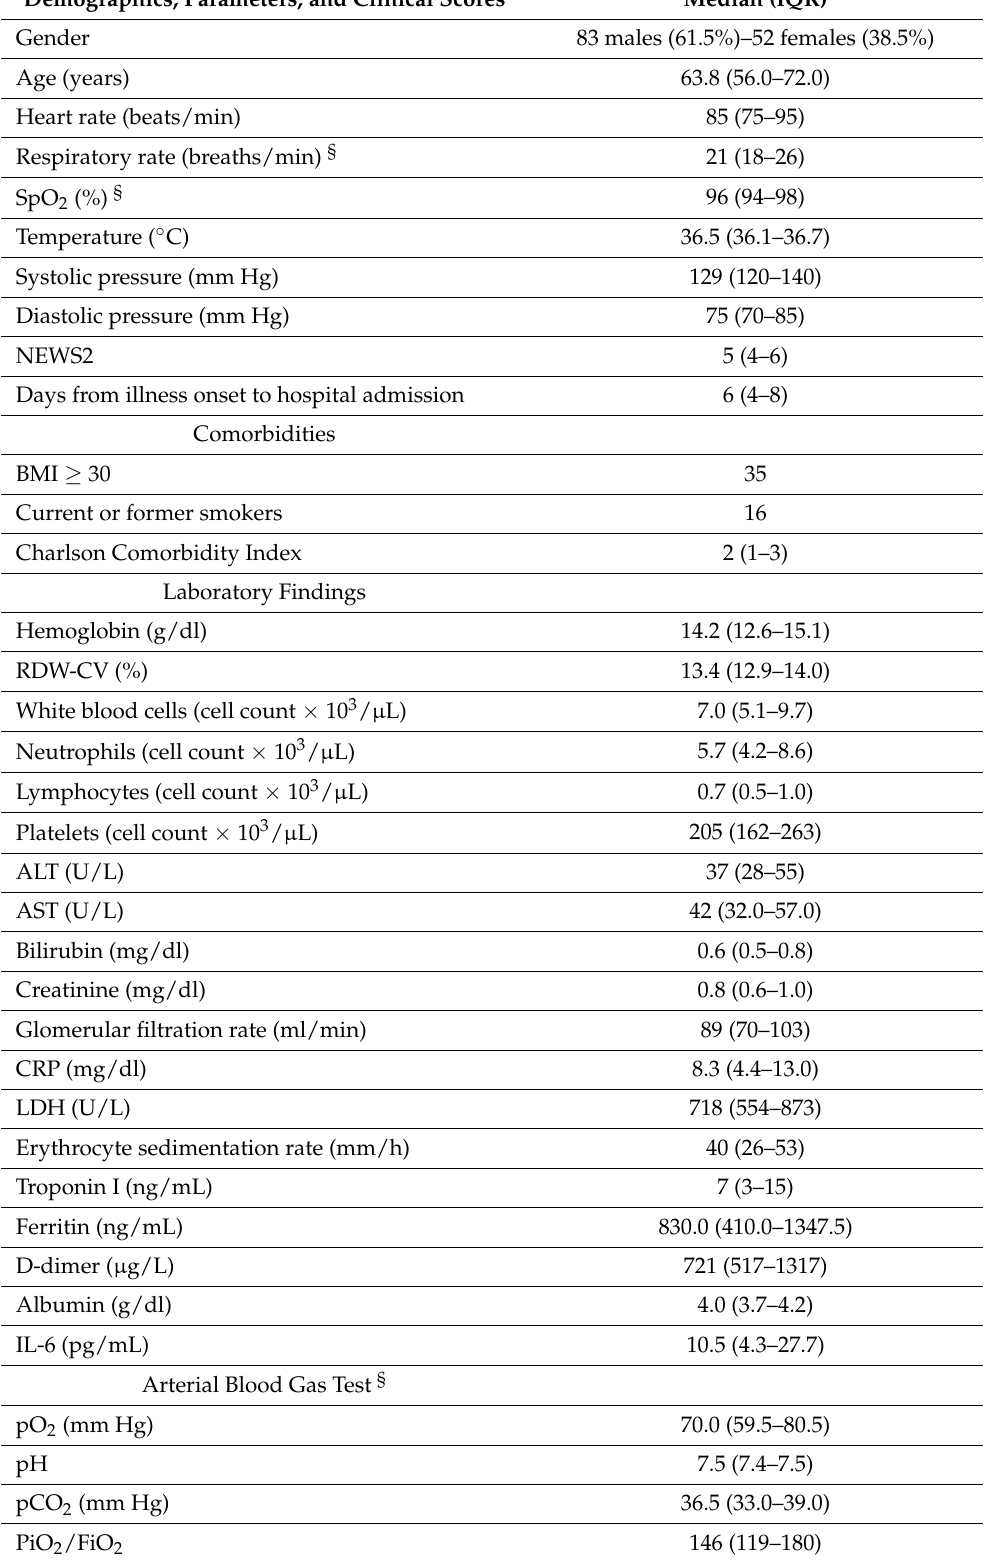
Table 1. Demographic and baseline clinical characteristics of the study population cohort. § refers to data obtained with oxygen supplementation. IQR = interquartile